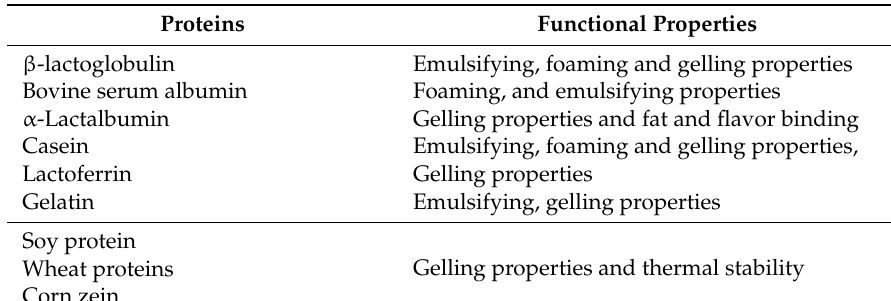
Table 1. Some examples of food proteins with the ability to form nanostructures and their related functional